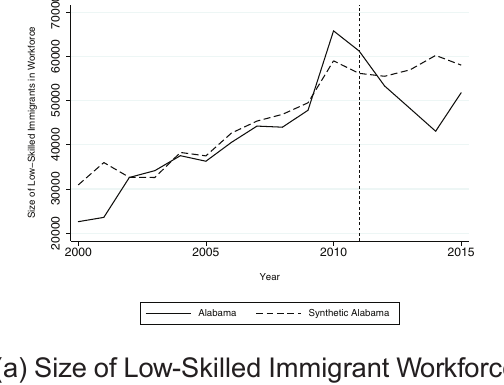
Alabama universal e-verify and size of low-skilled immigrant workforce